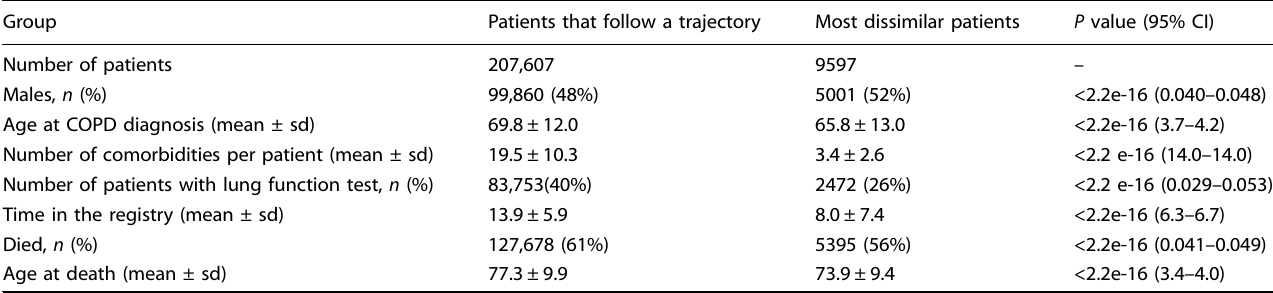
Table 1. Characteristics of COPD patients that follow at least one of the typical COPD trajectories and the group of most dissimilar COPD patients. Group